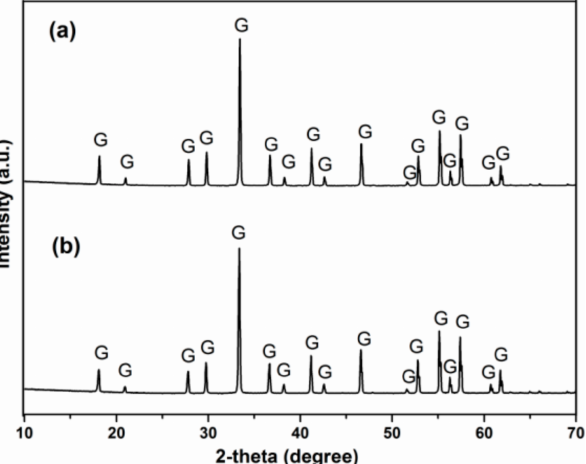
Figure 13. XRD patterns of the ceramics after vacuum sintering: ( a ) the precursor laying aside a month, compaction and sintering, ( b ) the precursor powers immediately compaction and